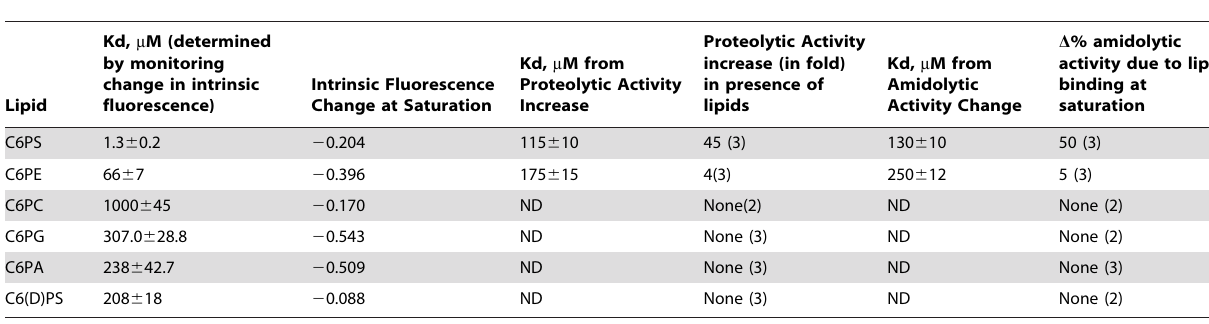
Table 1. Binding Affinity and Activity of FIXa in the Presence of Soluble Lipids.